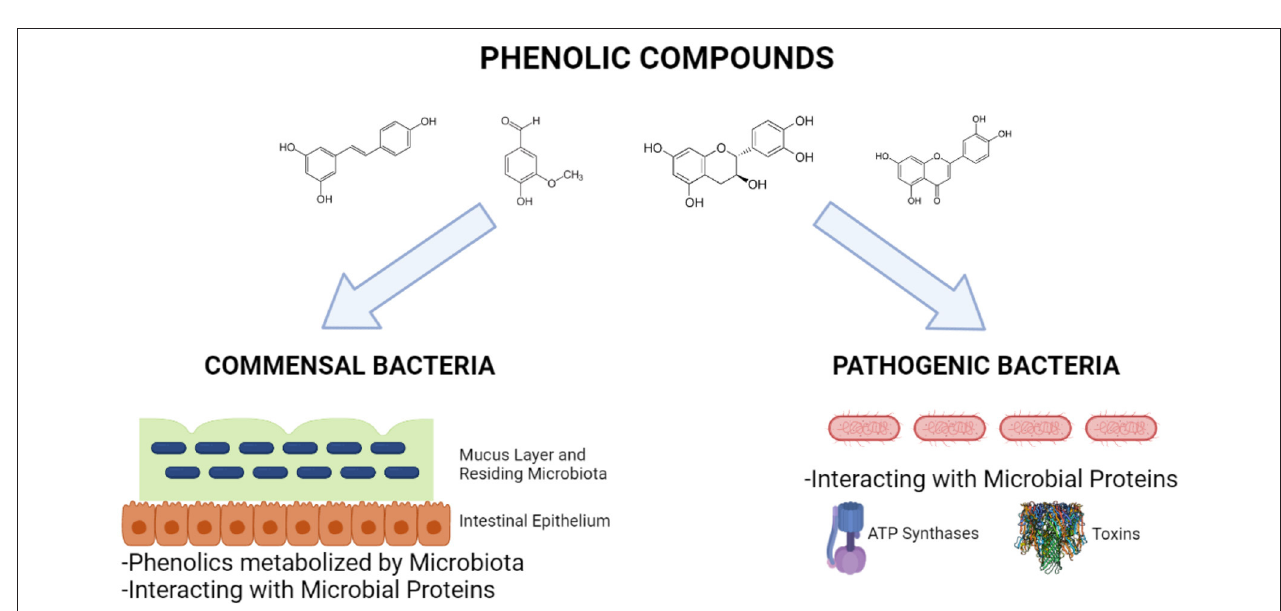
FIGURE 6 | Interactions of phenolic compounds with commensal and pathogenic bacteria (Created with